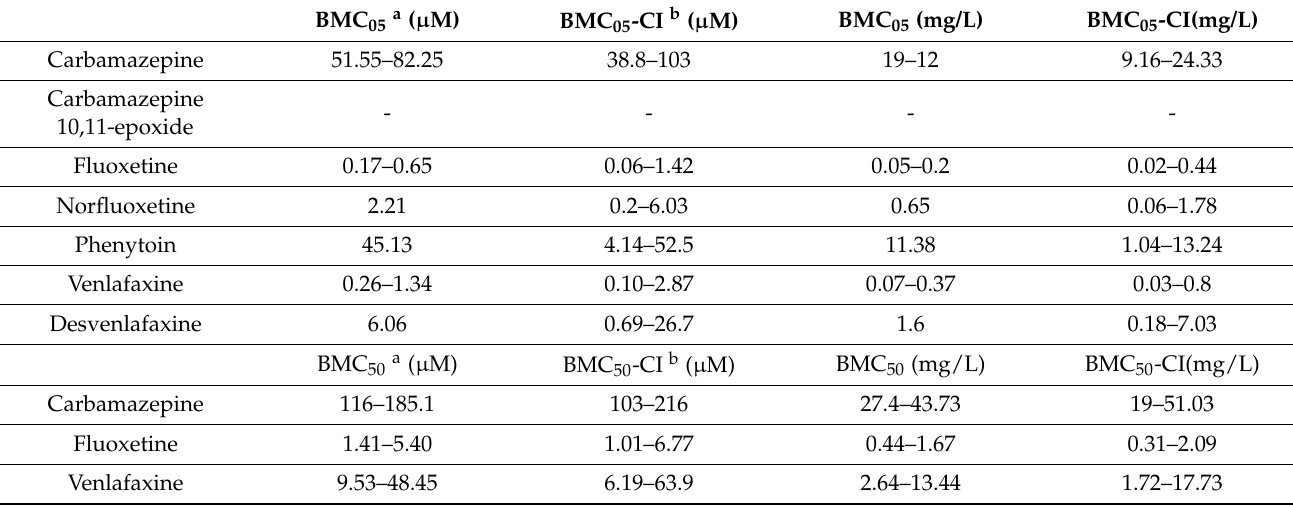
Figure 2. A dose–response curve plot showing five combined replicates of CBZ and FLX and four combined replicates of VNX (dark periods only). The individual experiments were used as covariate. One replicate of each compound was performed at VU, the others at RIVM. Symbols and error bars as in Figure 1B. Table 3. DR curves results of the single-compound analysis at experimental level, at 5% and 50%